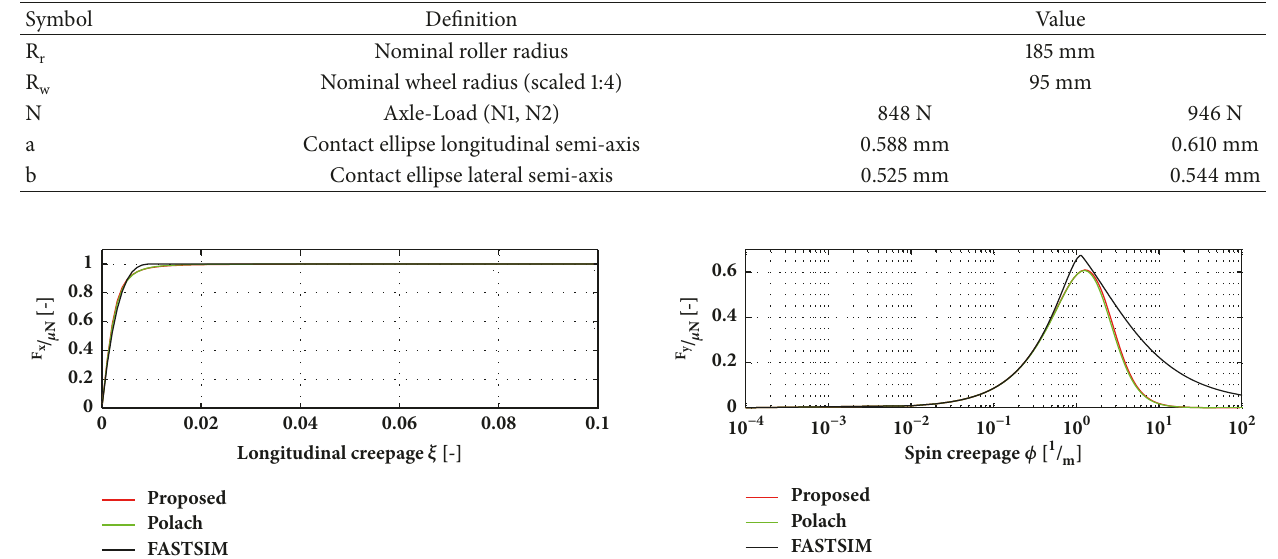
Table 3: Geometrical data of the roller-rig used during the tests.